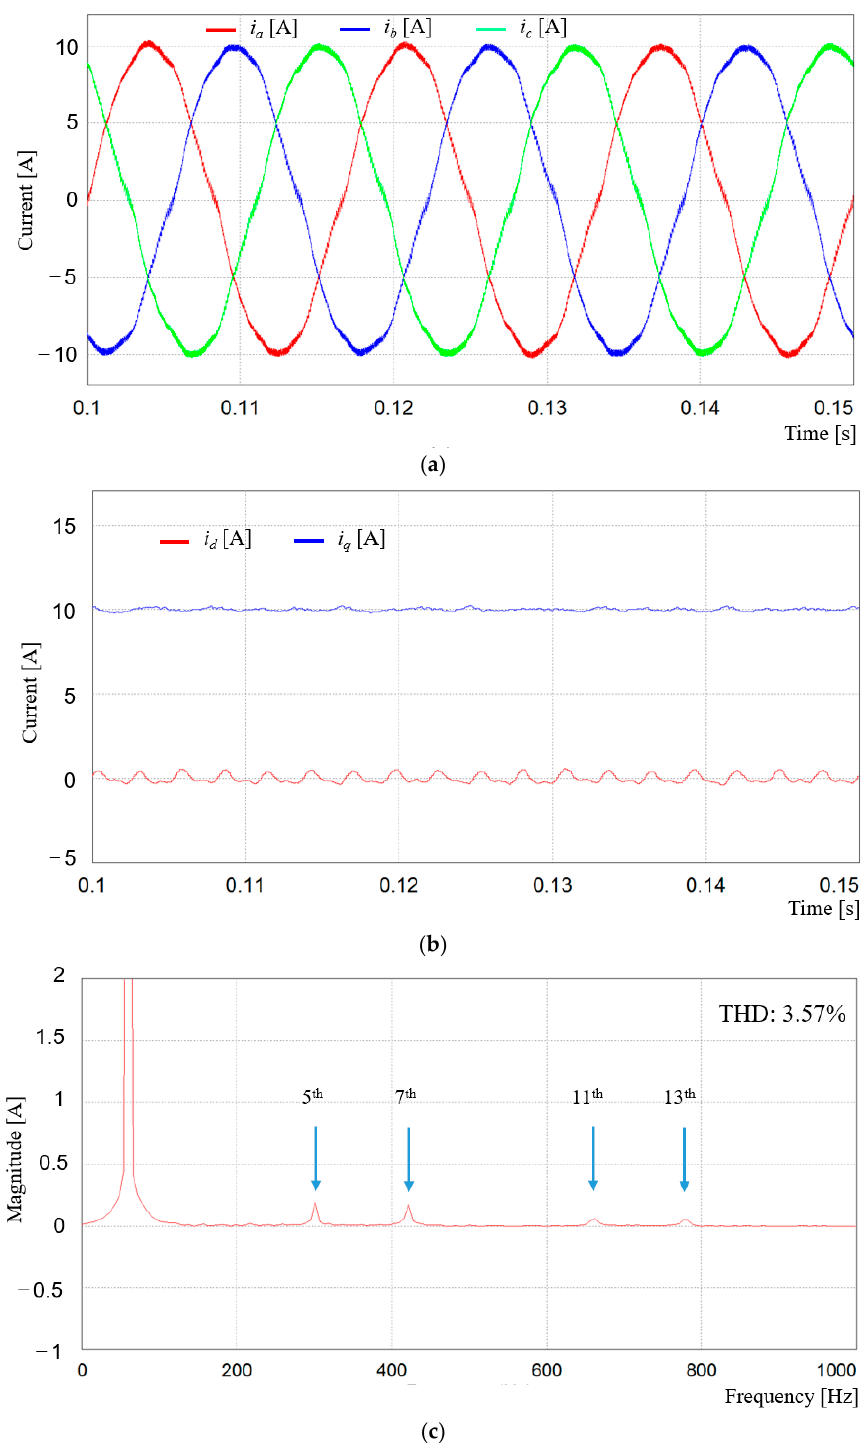
Figure 5. Inverter currents of the conventional PI decoupling controller under distorted grid voltages. ( a ) Phase currents; ( b ) q- axis and d- axis currents; ( c ) FFT result of a -phase current.